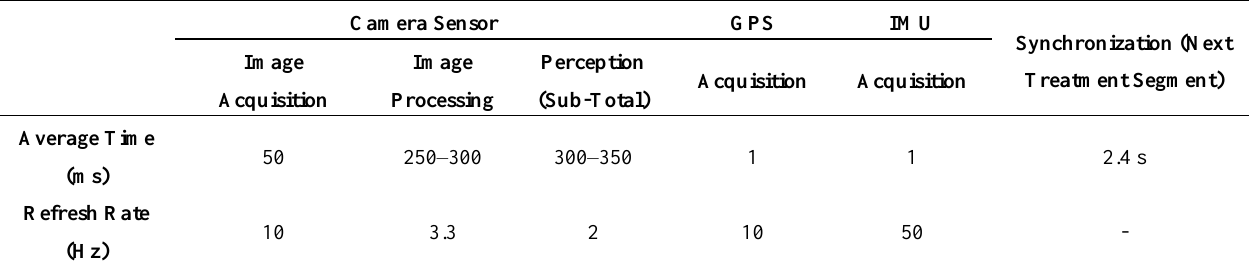
Table 1. Averaged times required by the perception system until data are available for control and